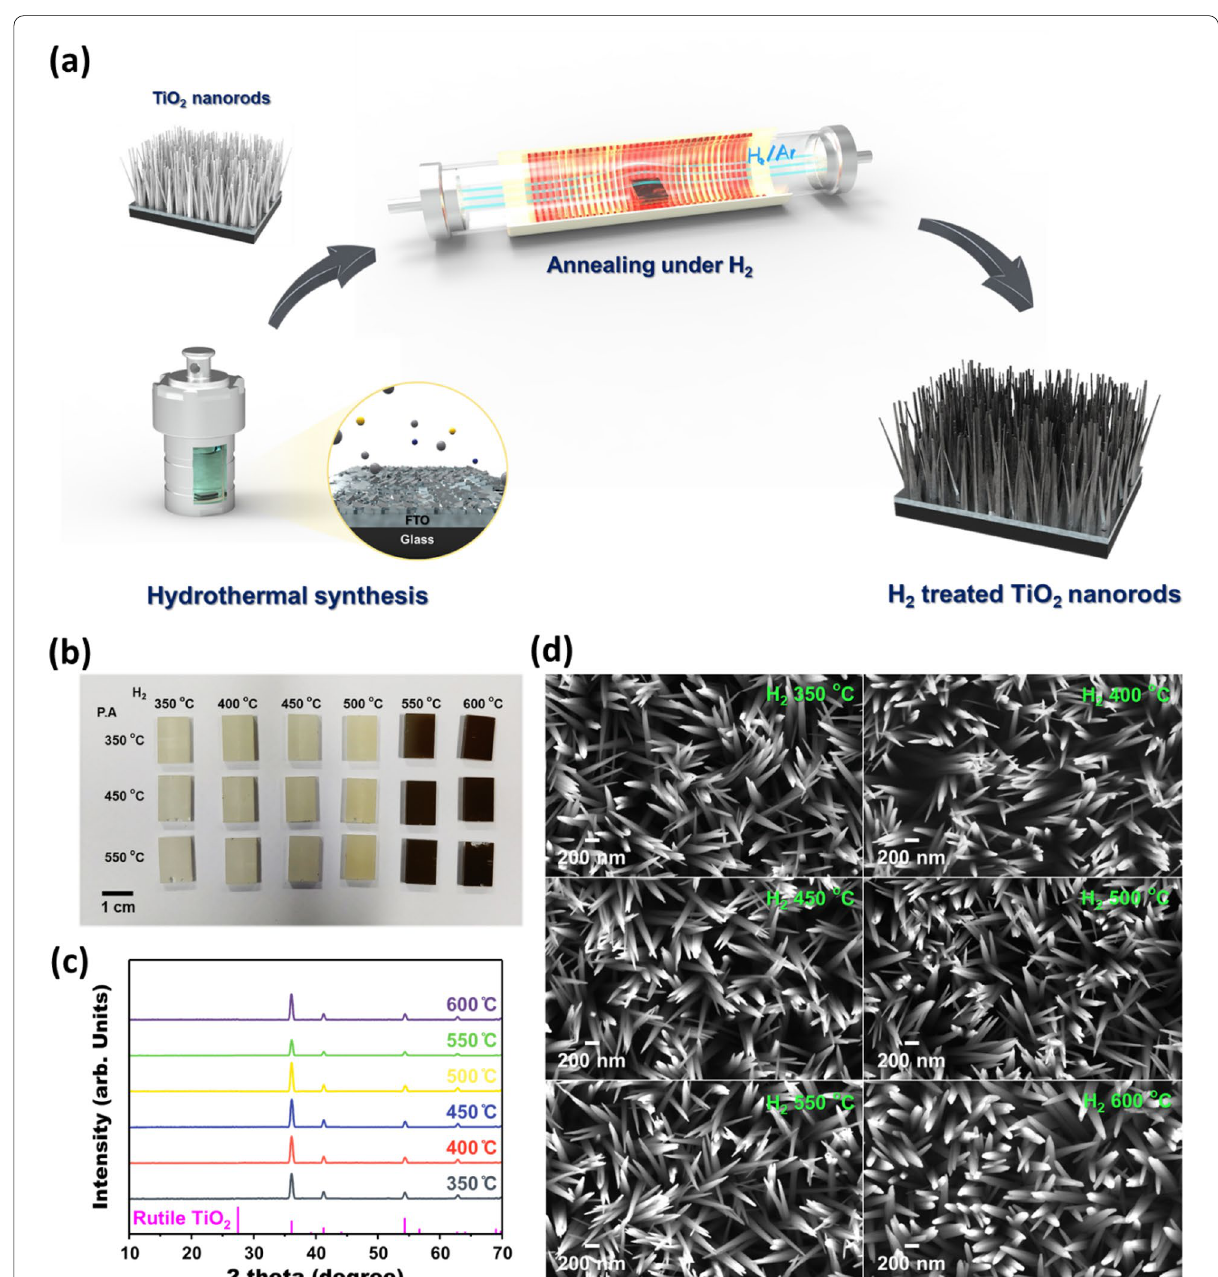
Fig. 1 a Schematics illustrating the facile procedure of H 2 treated S, N-doped TiO 2 nanorod arrays. b Optical image of the S, N-doped TiO 2 nanorod arrays under the various annealing condition. c XRD spectra and d SEM images for the 350 °C post-annealed S, N-doped TiO 2 samples under various H 2 treatment temperature. The XRD spectra were indexed using the JCPDS crystallographic database.